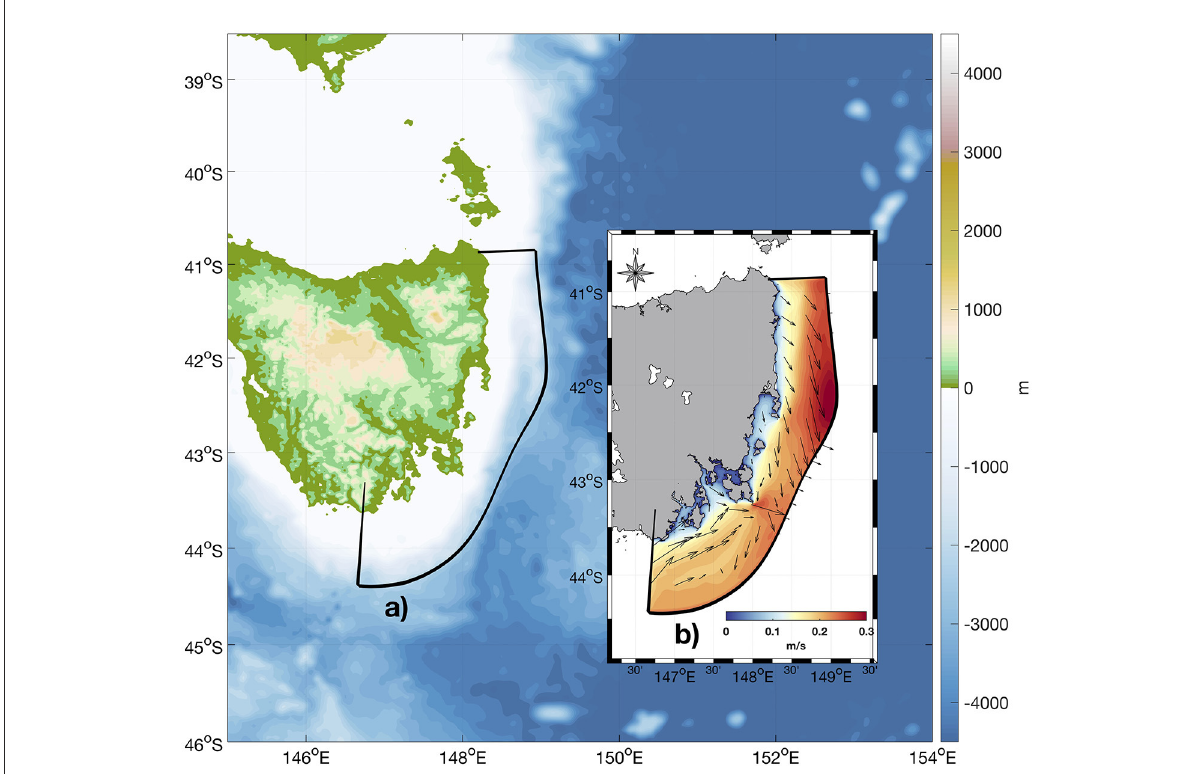
FIGURE1 (A) Topography of the domain in this study, where ETAS region is surrounded by black solid line. (B) Mean ocean currents in ETAS region during austral summer